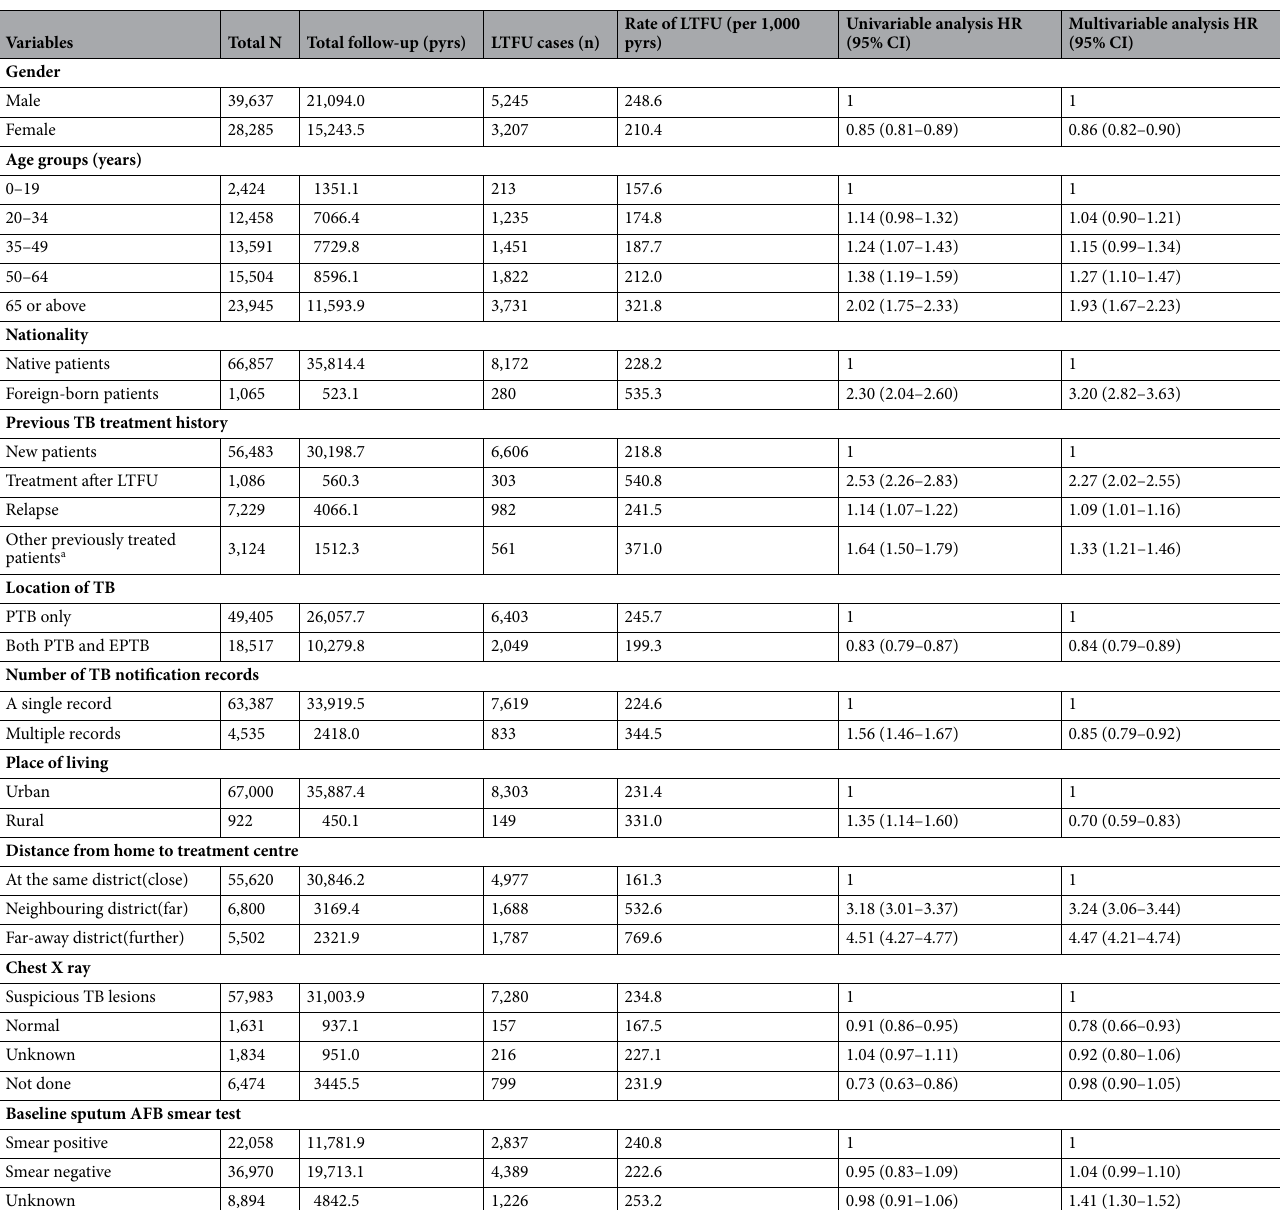
Table 6. Analysis of risk factors for loss to follow-up (versus all other outcomes) among the tuberculosis patients with pulmonary tuberculosis. a Composed of ‘treatment after failure patients’ and ‘other previously treated patients’ whose outcome of previous treatment was unknown or undocumented. HR hazard ratio, CI confidence interval, LTFU loss to follow-up, TB tuberculosis, PTB pulmonary tuberculosis, EPTB extra- pulmonary tuberculosis, AFB acid-fast